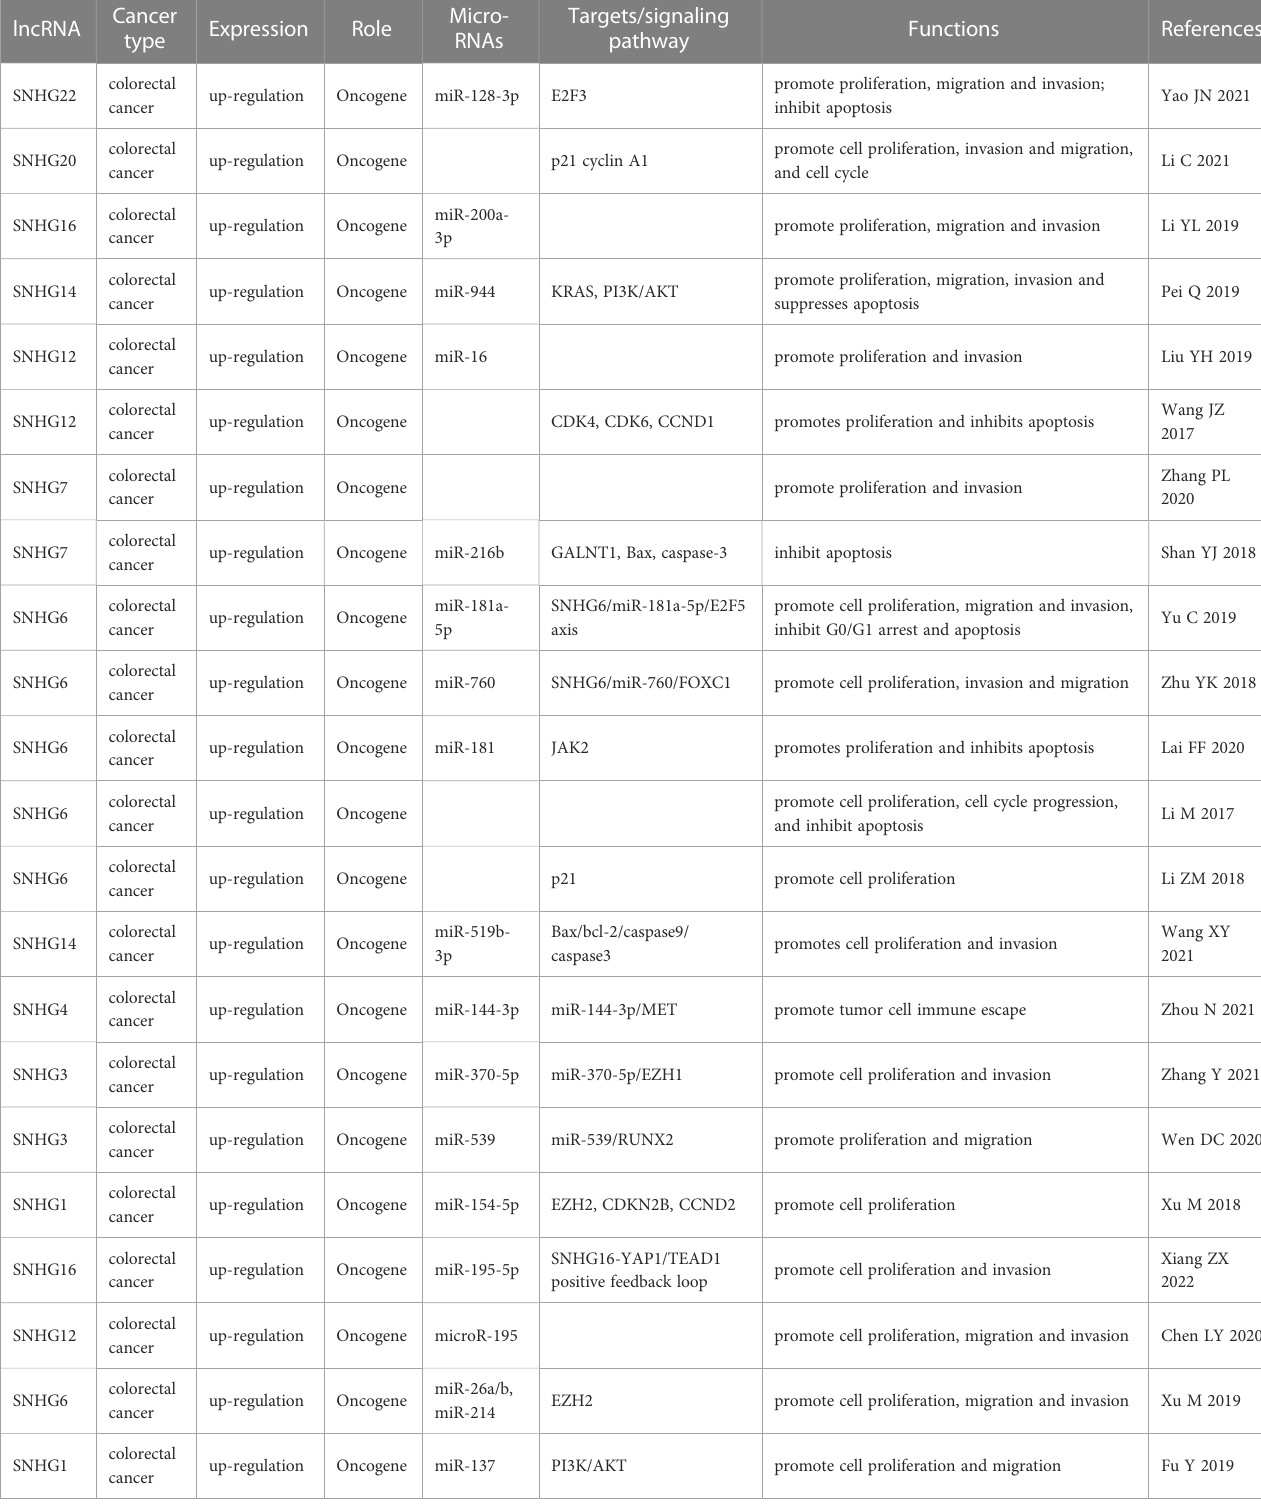
TABLE 5 Transition of cell phenotype and related molecular mechanisms with abnormal lncRNA SNHGs expression in colorectal